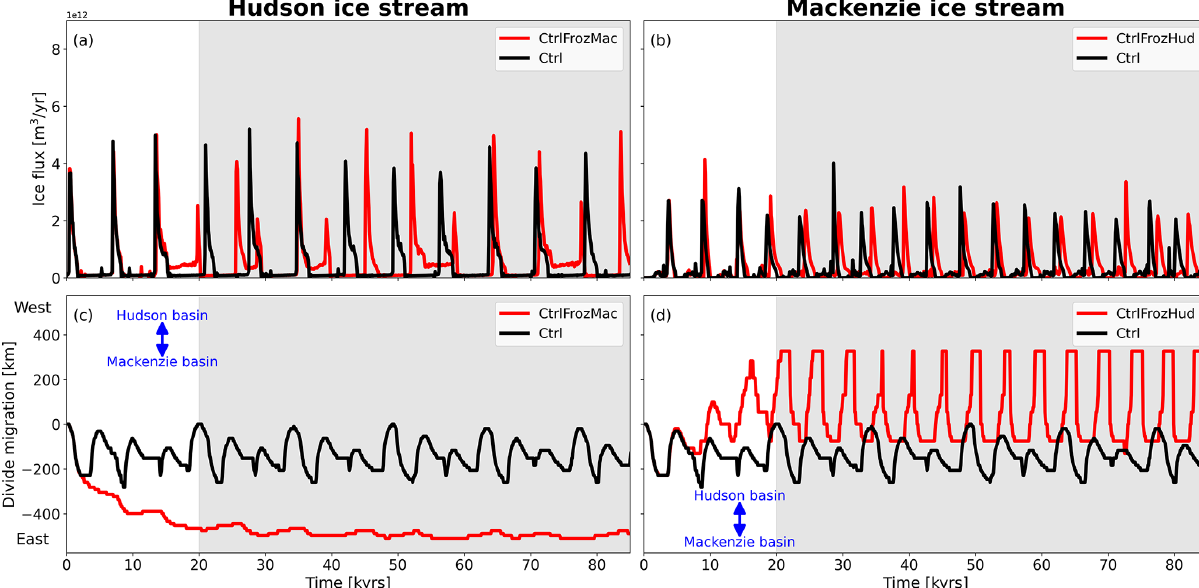
Figure 11. Differences induced by artificially suppressing surge events in one of the surge regions. Panels (a, b) show time series of ice flux through the flux gates (Fig. 1). Panels (c, d) show the temporal evolution of the ice divide position (Fig. 1).